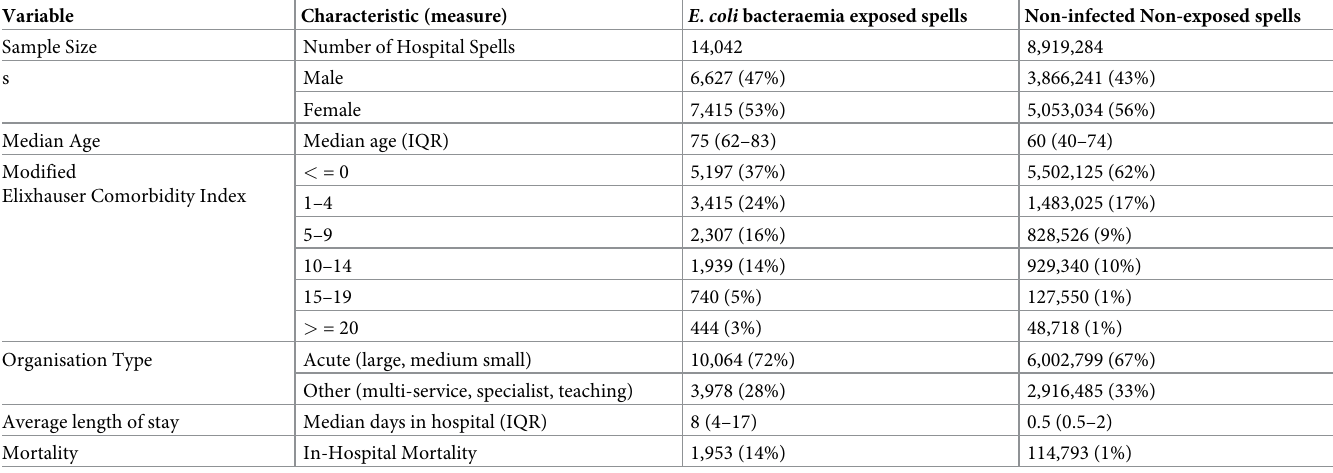
Table 1. Descriptive statistics for exposed and non-exposed hospital